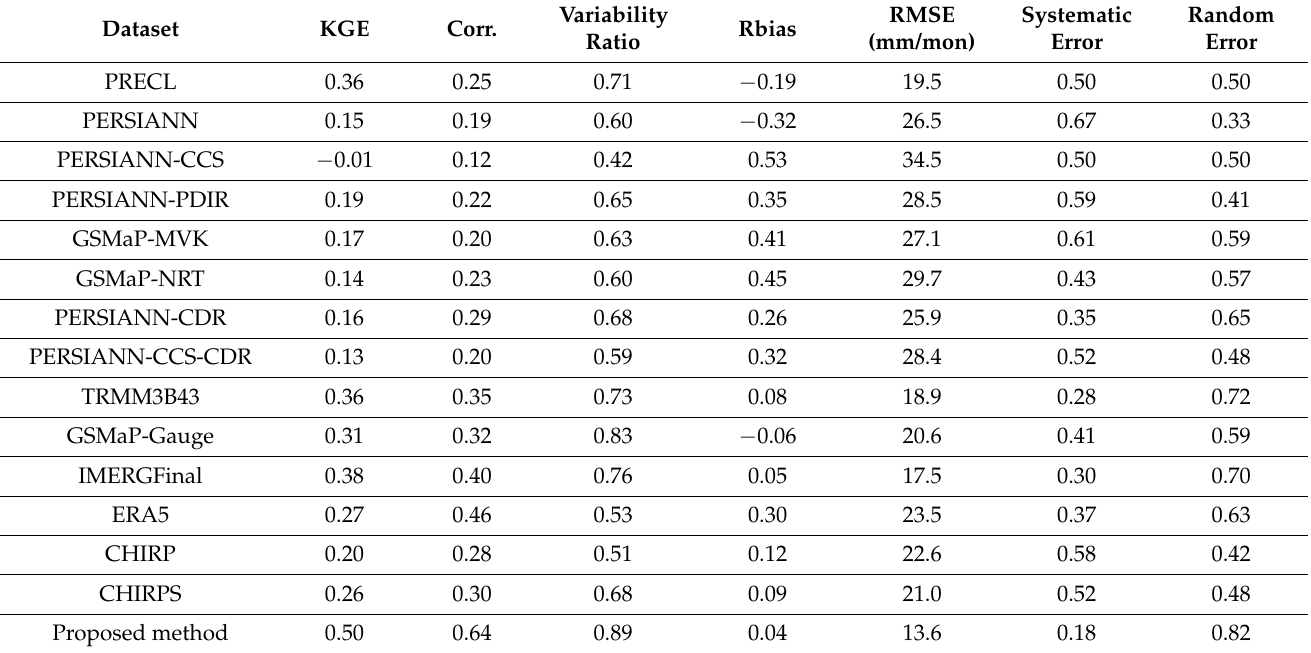
Table 4. Results of accuracy evaluation of different precipitation products based on point-to-pixel strategy in geographical location of validation stations.